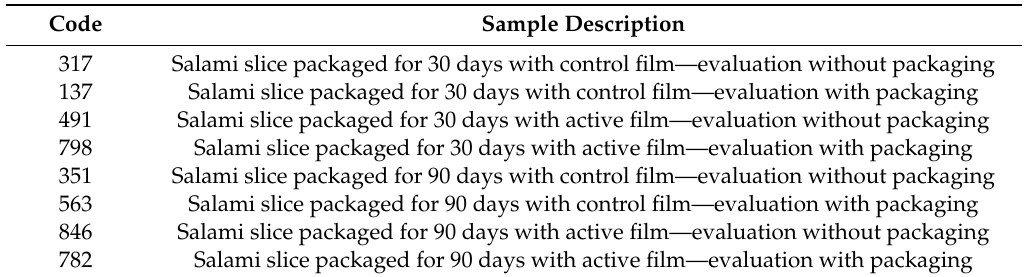
Table 2. Decoding of the samples in study presented in Figure